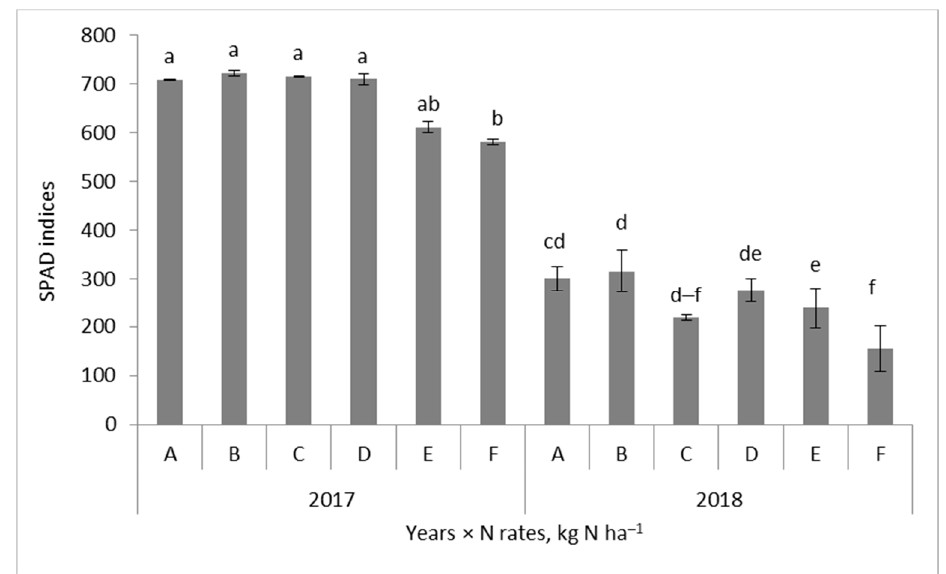
Figure 4. Effect of plant protection methods on the SPAD index of winter wheat. Similar letters indicate a lack of significant differences between experimental treatments using Tukey’s test. The vertical bar in the column is the standard error of the mean. Table 4. Nitrogen content in leaves, SPAD indices, and winter wheat infestation by pathogens during the growing season.